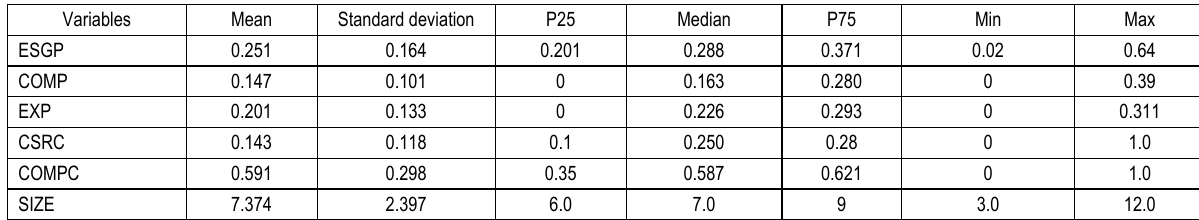
Table 3. Descriptive